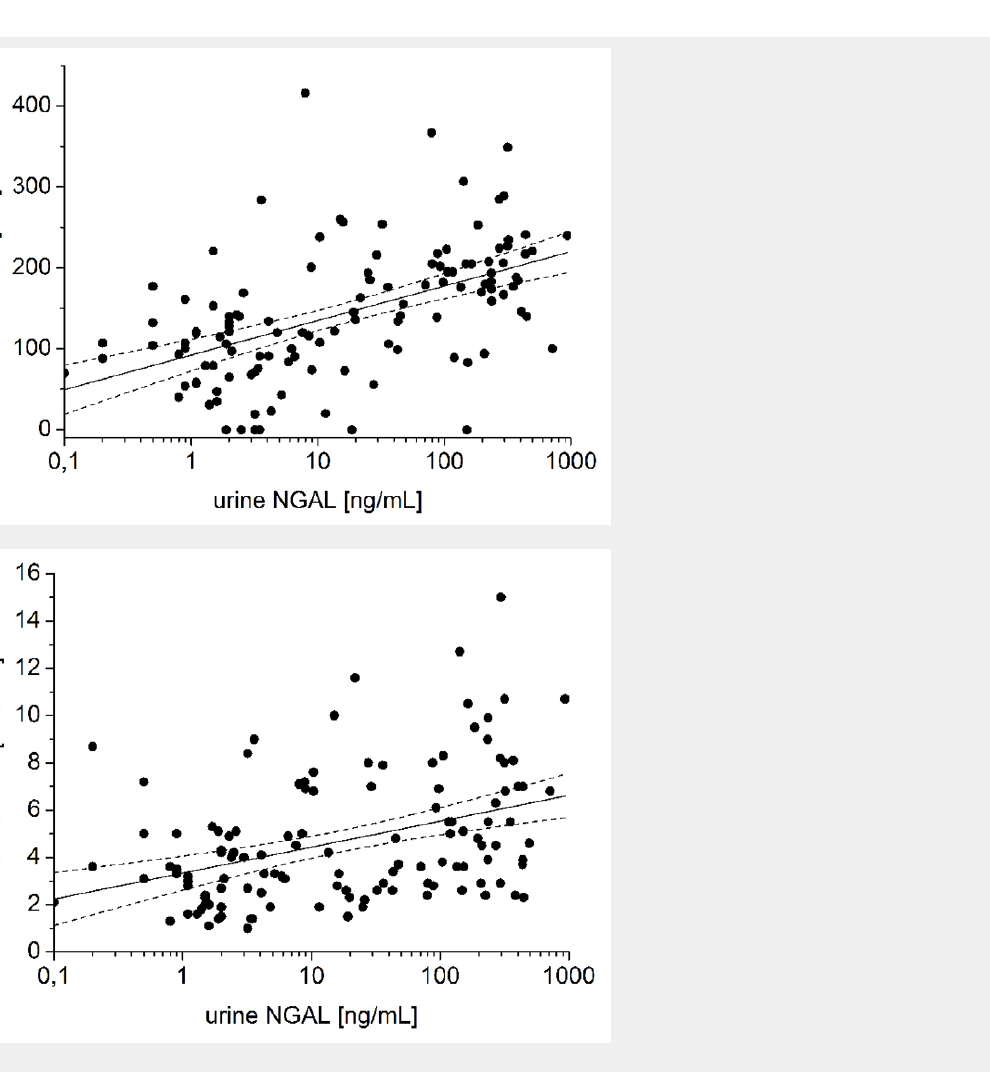
Figure 4 Correlations between urine NGAL 2 hours after the end of cardiopulmonary bypass (CPB) and (a) duration of CPB (P <0.01), and (b) serum lactate concentration (P <0.01). Solid and dotted lines represent the regression line and the 95% confidence interval,